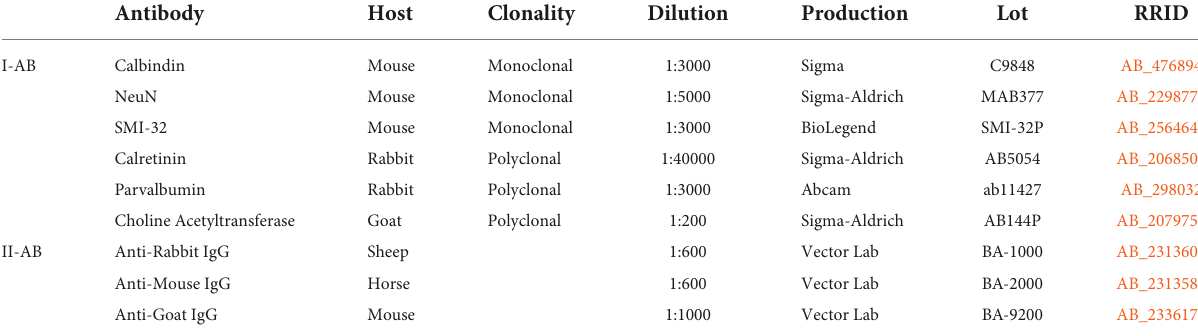
TABLE 1 The list of used antibodies